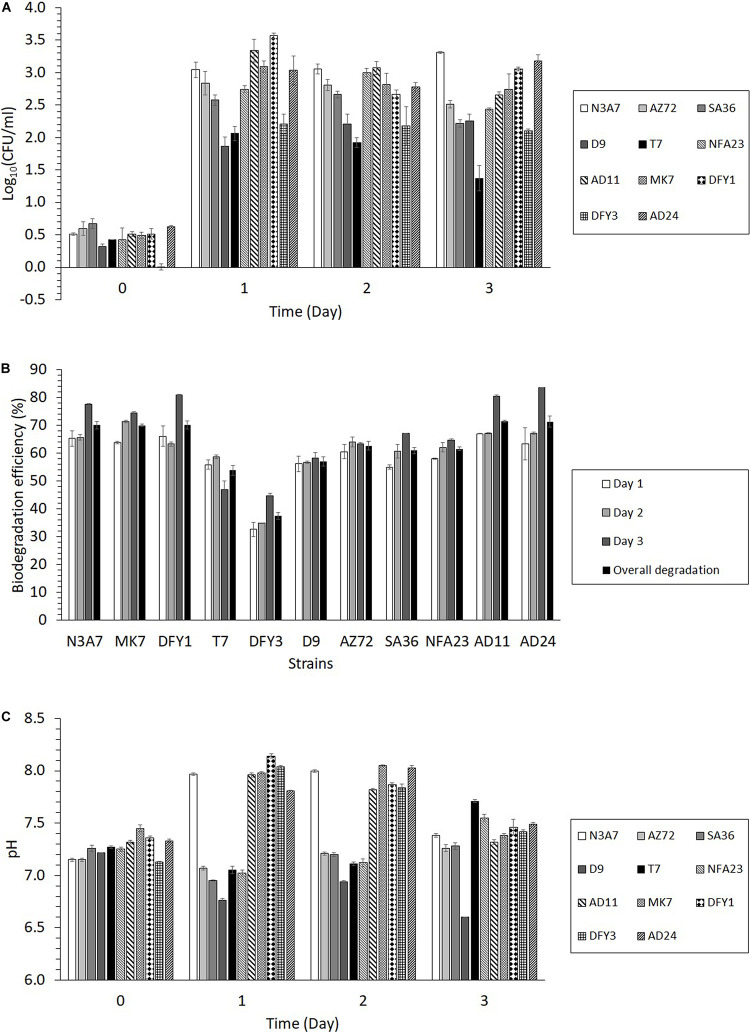
Growth, degradation efficiency, and changes in pH of growth medium during the degradation of crude oil. (A) Bacterial growth of the 11 strains in 2% (w/v) crude oil B for 3 days, (B) Crude oil biodegradation efficiency of the 11 strains from days 1 to 3 and overall degradation, (C) The pH of the medium during the degradation of crude oil (p < 0.05). The overall degradation is the average degradation from biodegradation efficiency on days 1 to 3. The crude oil biodegradation efficiency was calculated by comparing the peak areas of the inoculated sample with the peak areas of the control from GC–MS analysis.